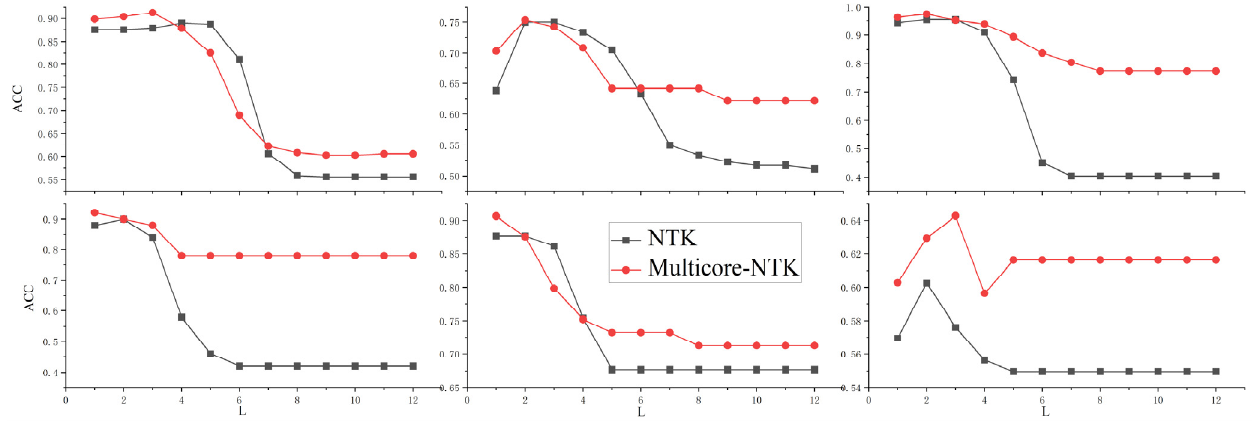
Figure 3. The effect of changing the network parameters L on the accuracy of the model, each graph corresponds to a different dataset.